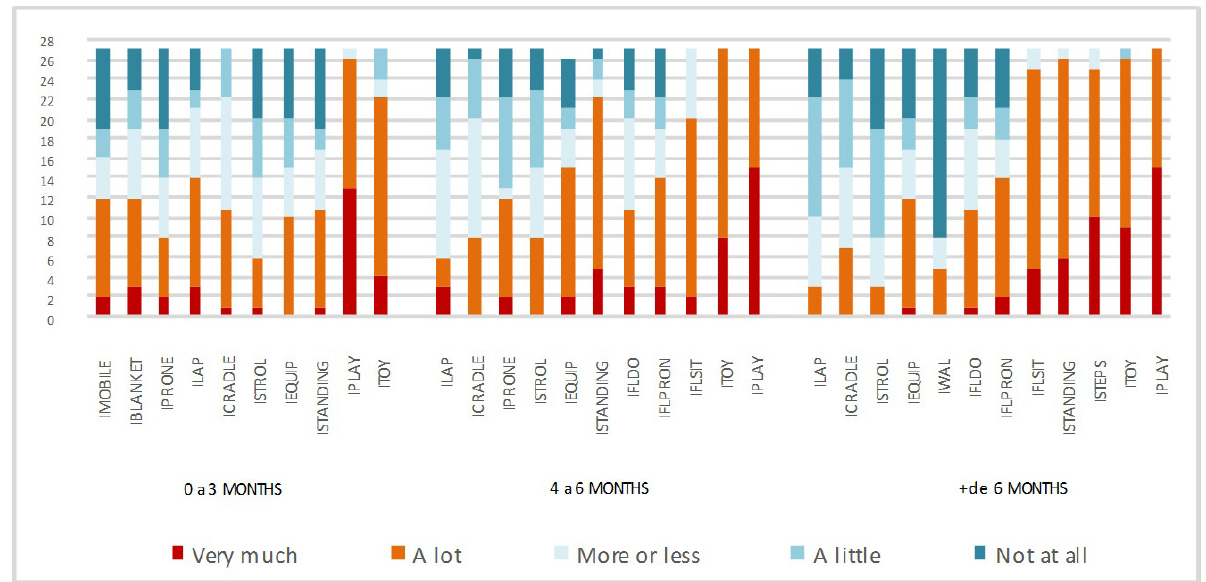
Figure 2 - Number of answers to the questionnaire – parental beliefs. Note: I: importance; STROL: Stroller; EQUIP: Equipment; TOY: Whether the caregivers gave toys; FLDO: On the floor in dorsal; FLPRON: